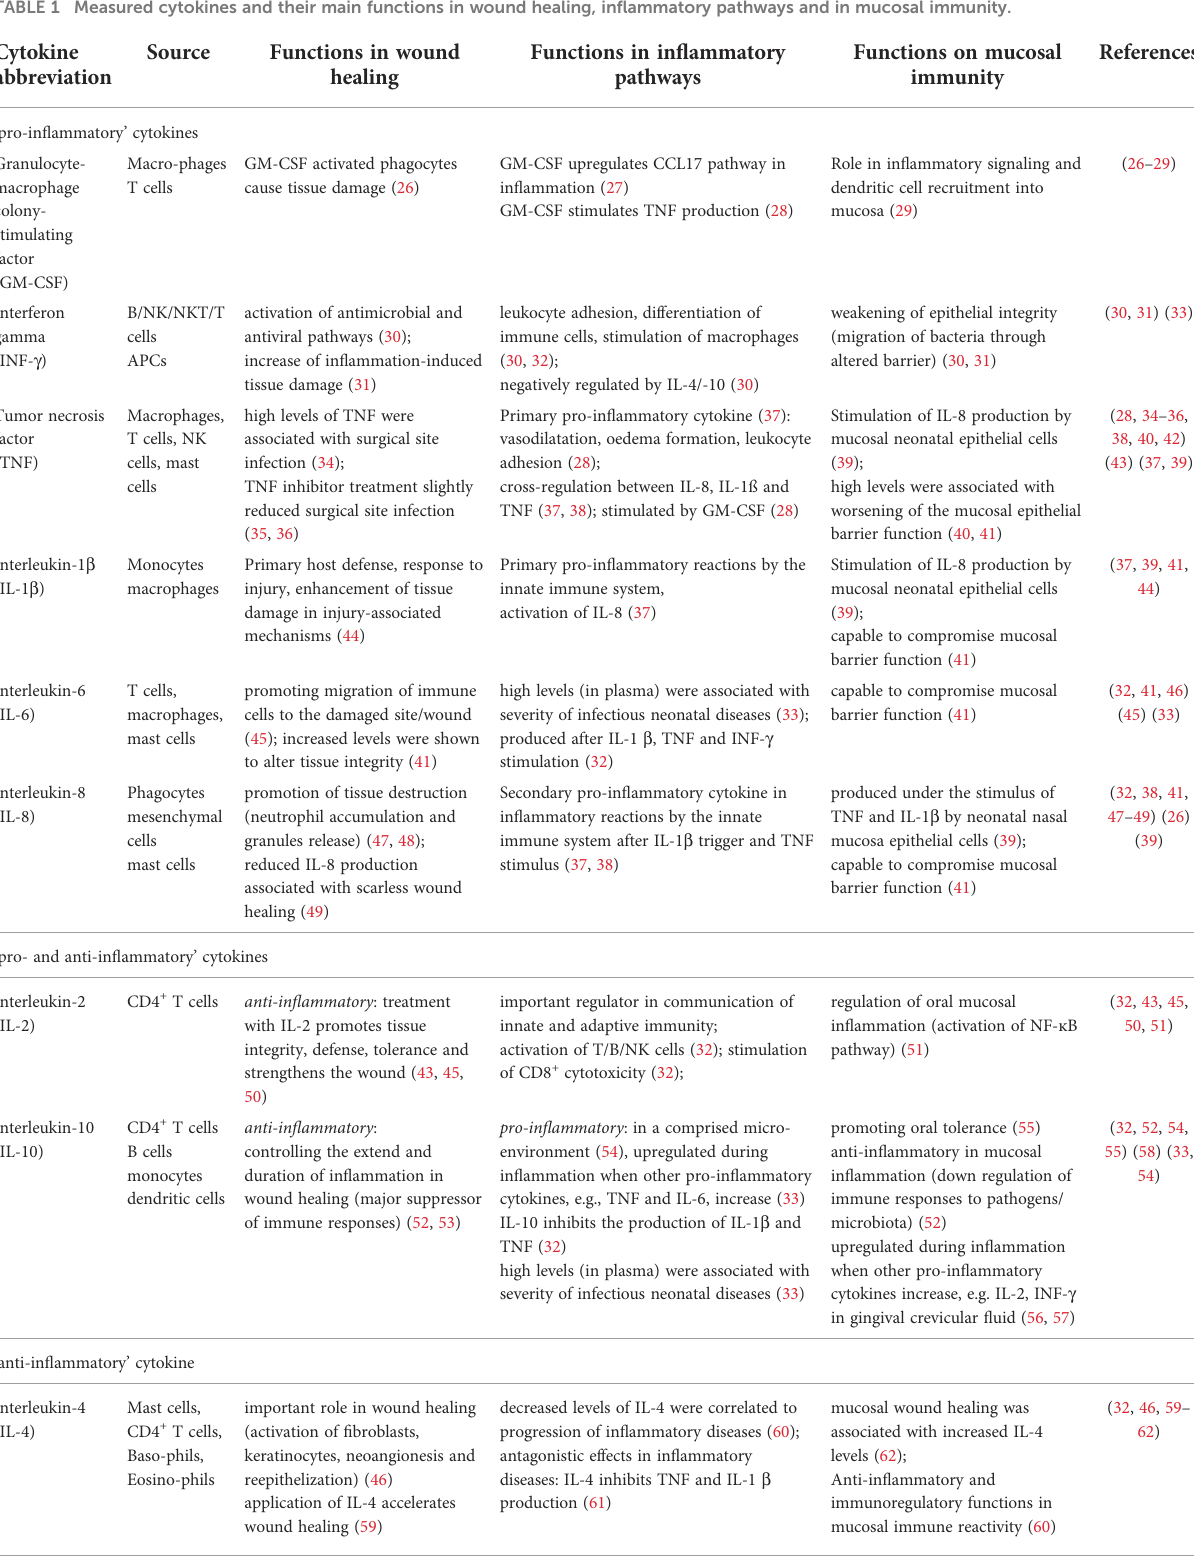
TABLE 1 Measured cytokines and their main functions in wound healing, in fl ammatory pathways and in mucosal immunity. Cytokine